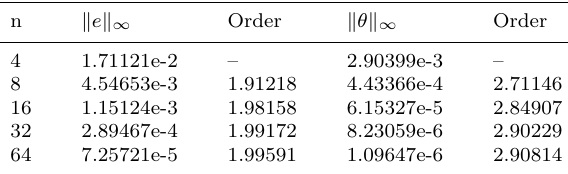
Table 2. Numerical results for example